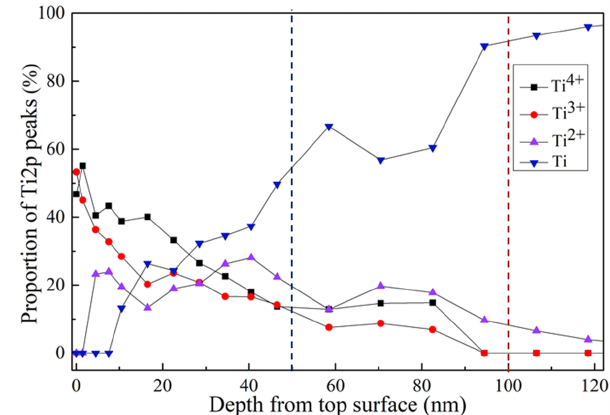
Figure 2. Proportion of different Ti valence states of the plasma oxidation surface in depth from the top surface.